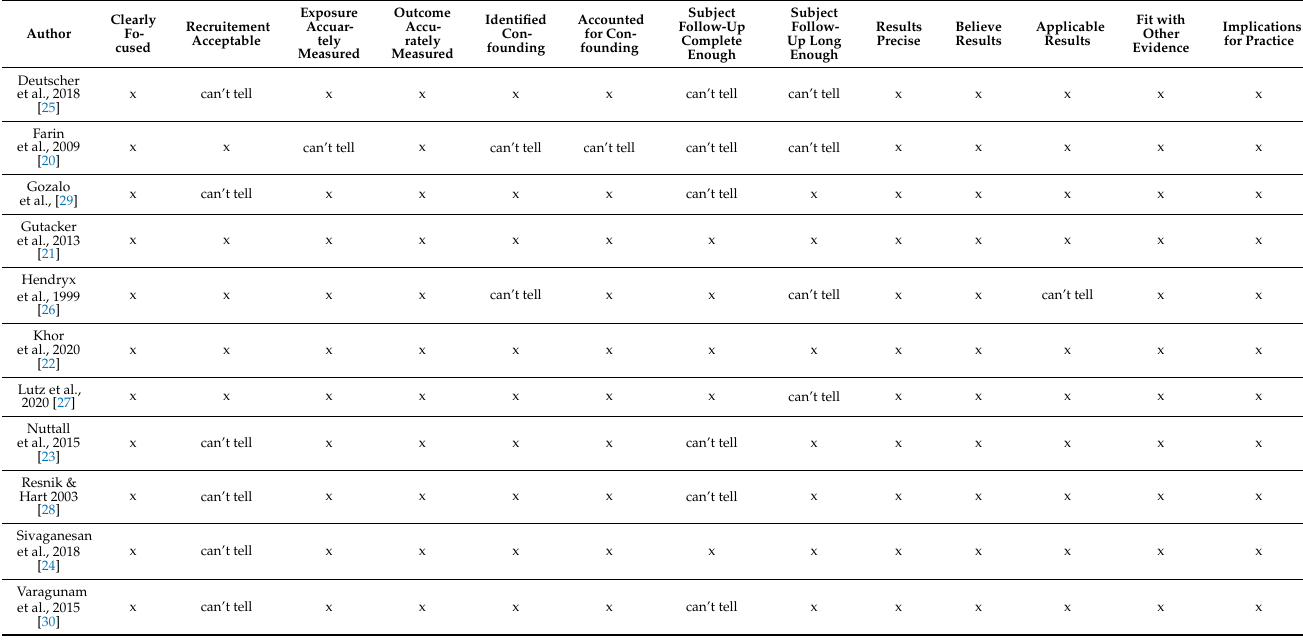
Table A1. CASP tool for included